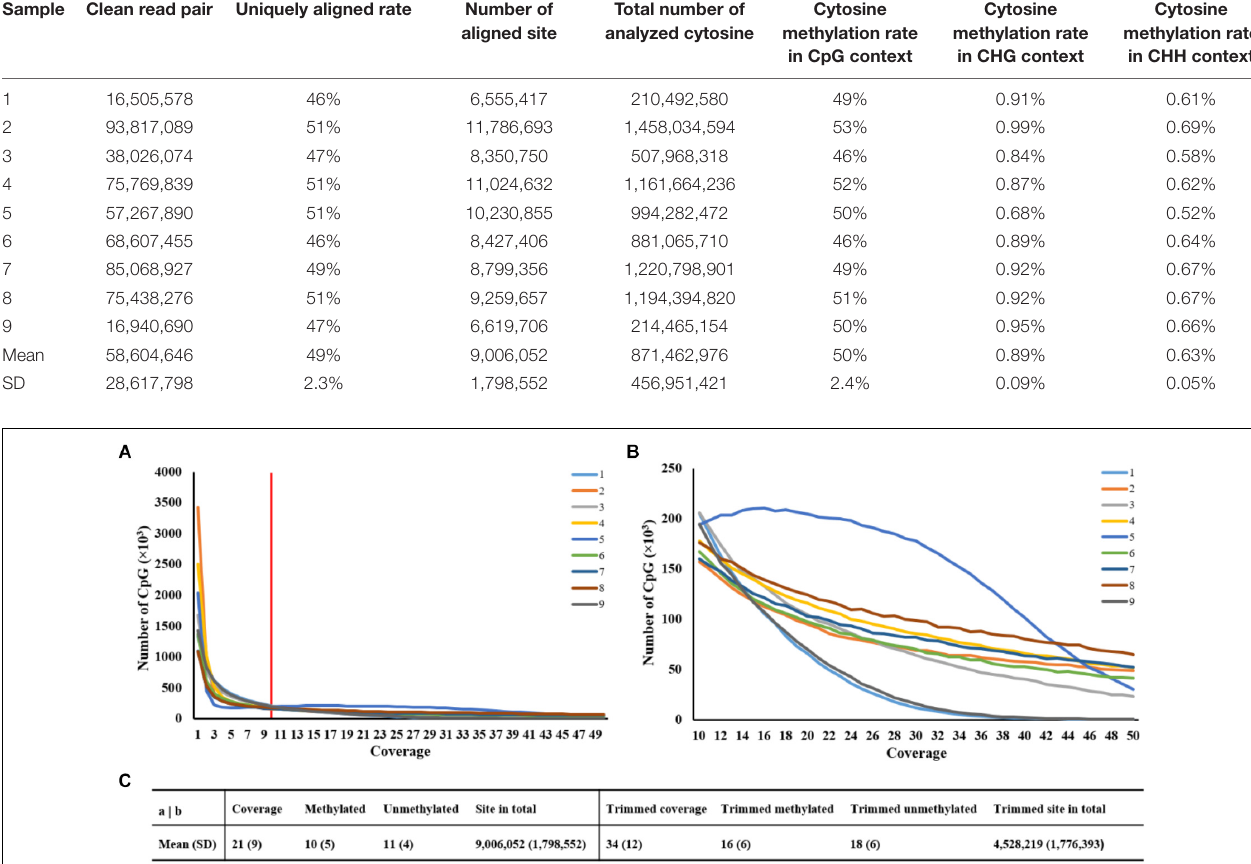
TABLE 1 | Statistics of clean reads’ alignment with porcine reference genome (Sscrofa11.1/susScr11) and methylation rates in CpG, CHG, and CHH contexts. Sample Clean read pair Uniquely aligned rate